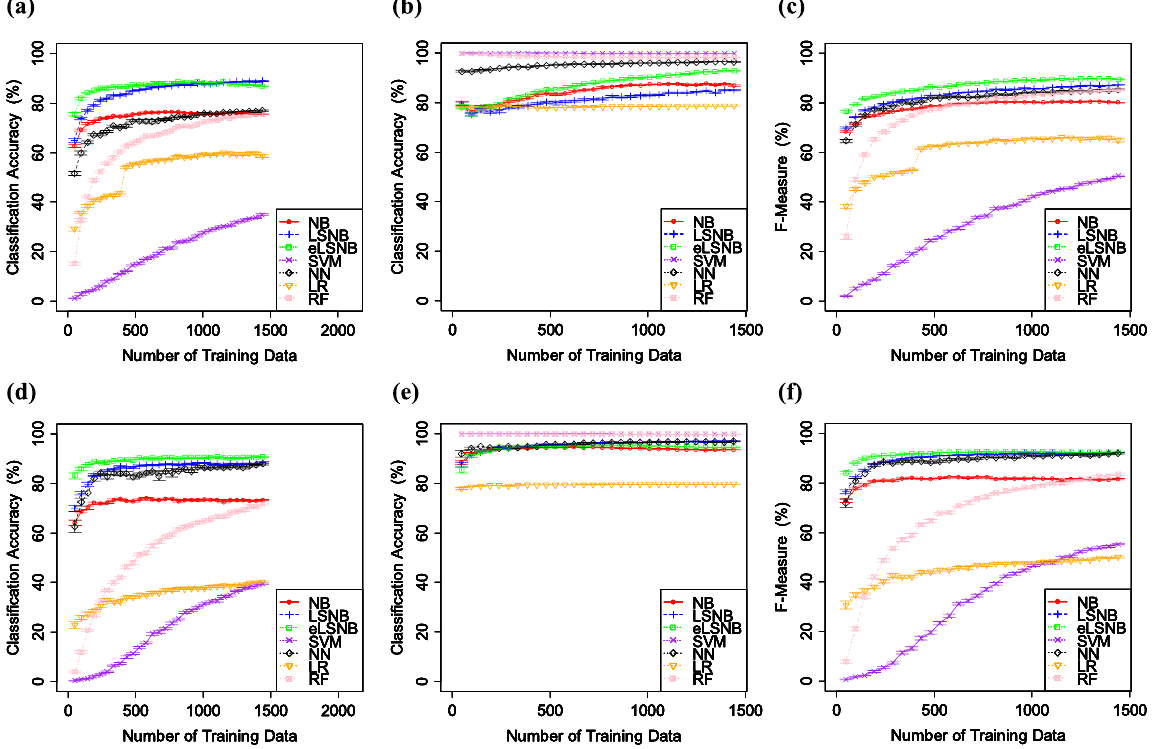
Figure 4. ( a ) spam classification accuracy, ( b ) ham classification accuracy and ( c ) F-measure values for SpamAssassin. ( d ) spam classification accuracy, ( e ) ham classification accuracy and ( f ) F-measure values for Ling-Spam. The error bars indicate the standard